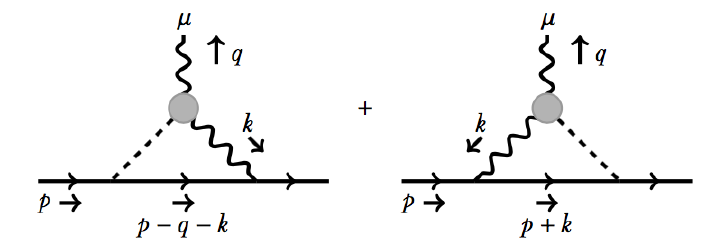
Figure 2 . Attaching the inner-loop vertex i(cid:0) (cid:22)(cid:23) to a fermion line to generate an electric dipole moment.